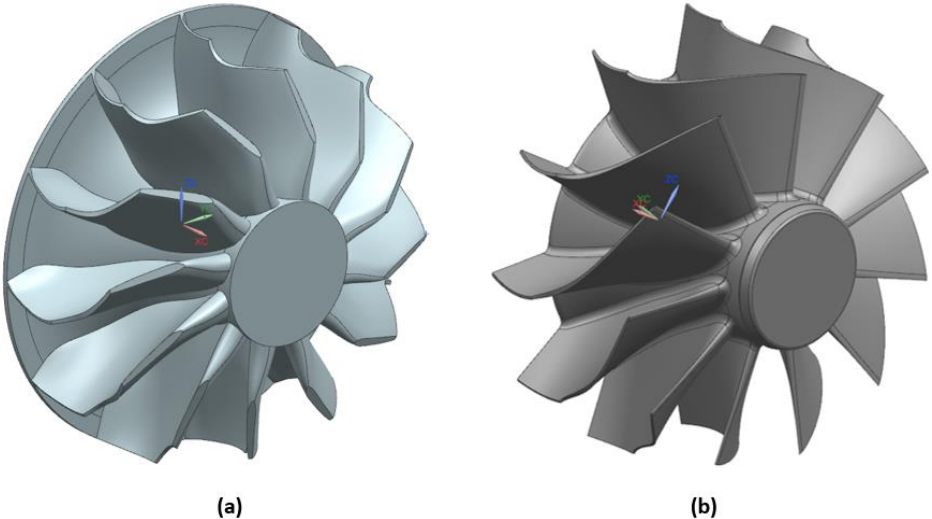
Figure 1. The geometries of ( a ) Rotor A — older version of turbine wheel and ( b ) Rotor B — latest version of turbine wheel (scaled to match the diameter of the Rotor A).